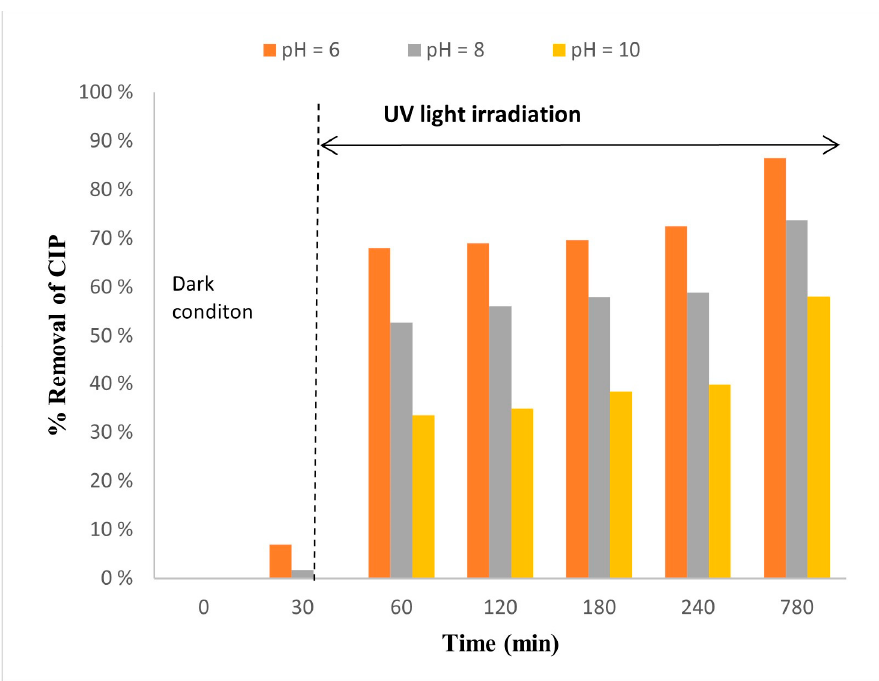
Figure 10. Effect of pH to conversion of removing CIP.